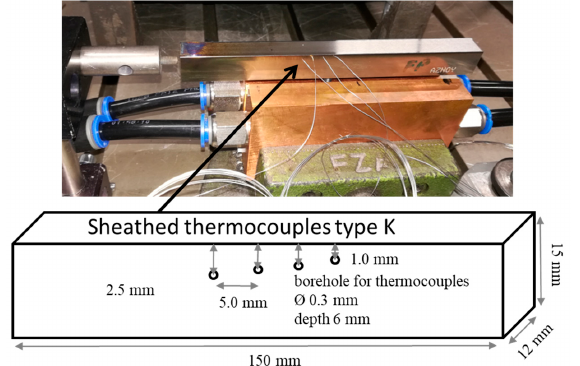
Figure 5. Setup for laser hardening of AISI 4140 with sheathed thermocouple typ K Ø 0.25